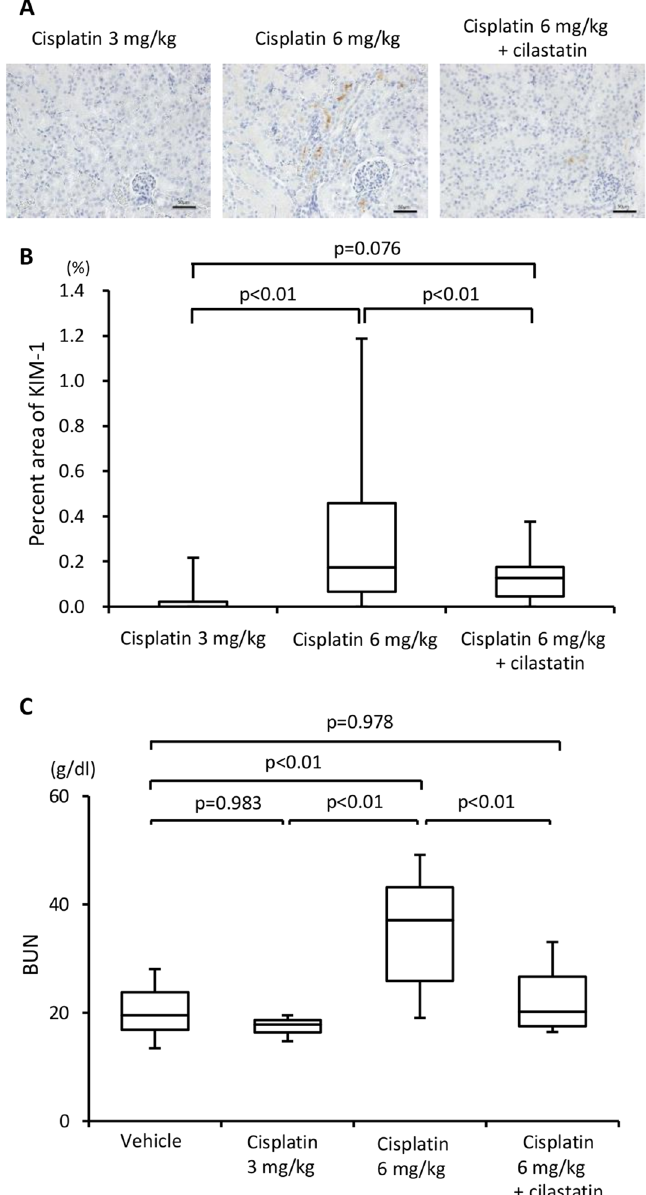
Figure 1. Administration of cilastatin suppressed cisplatin-induced kidney injury. ( A ) BALB/cA mice were administered cisplatin i.p. at a dose of 3 mg/kg or 6 mg/kg on days 0, 3 and 6. Mice that received 6 mg/kg cisplatin were treated s.c. with cilastatin (100 mg/kg) from days 0 to 6 or left untreated. Nine days after the first administration of cisplatin, the kidneys were harvested and stained with KIM-1. ( B ) The expression of KIM-1 was scored to evaluate the percentage of injured tubules. The KIM-1 staining scores were lower in mice treated with cisplatin with cilastatin combination therapy. ( C ) BUN was measured by enzymatic